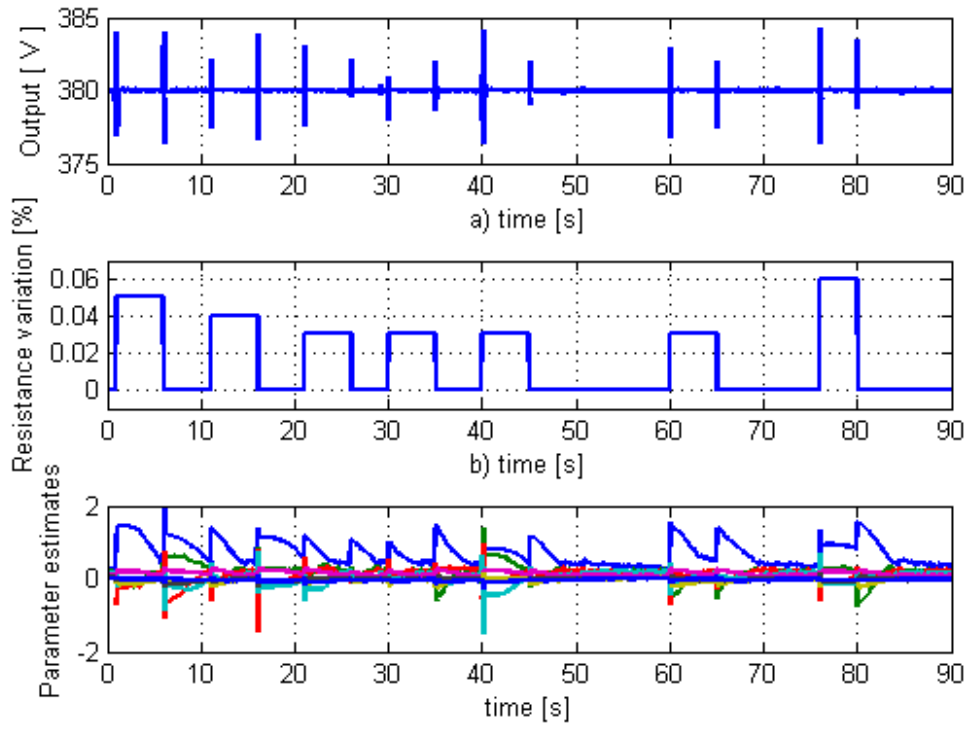
Figure 15. Robustness test (electrical resistance variations): ( a ) Controlled output (terminal voltage); ( b ) Electrical resistance variations (disturbance); ( c ) Parameters estimates.